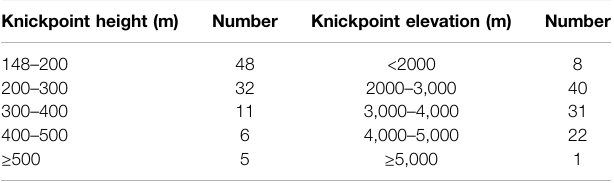
TABLE 3 | Height and elevation characteristics of knickpoints in the upper Indus